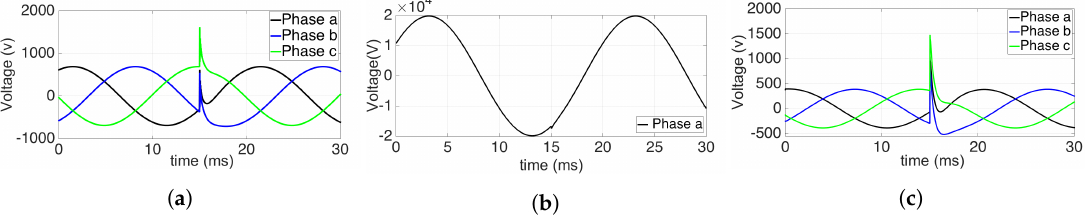
Figure 3. Impact of PMGS on transient overvoltages. ( a ) LV side of the main transformer; ( b ) HV side of the main transformer from node to ground; ( c ) control